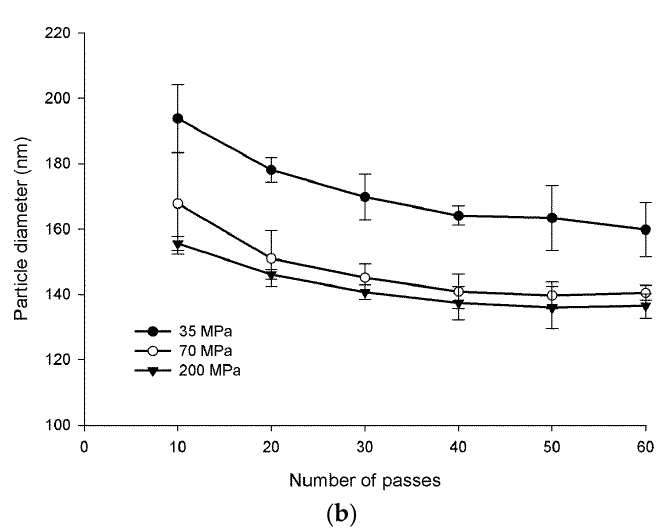
Figure 3. α -Glucans were homogenized in water to clarity to form nanoparticles ( a ). Nanoparticle size as a function of pressure and passes through homogenization ( b ).